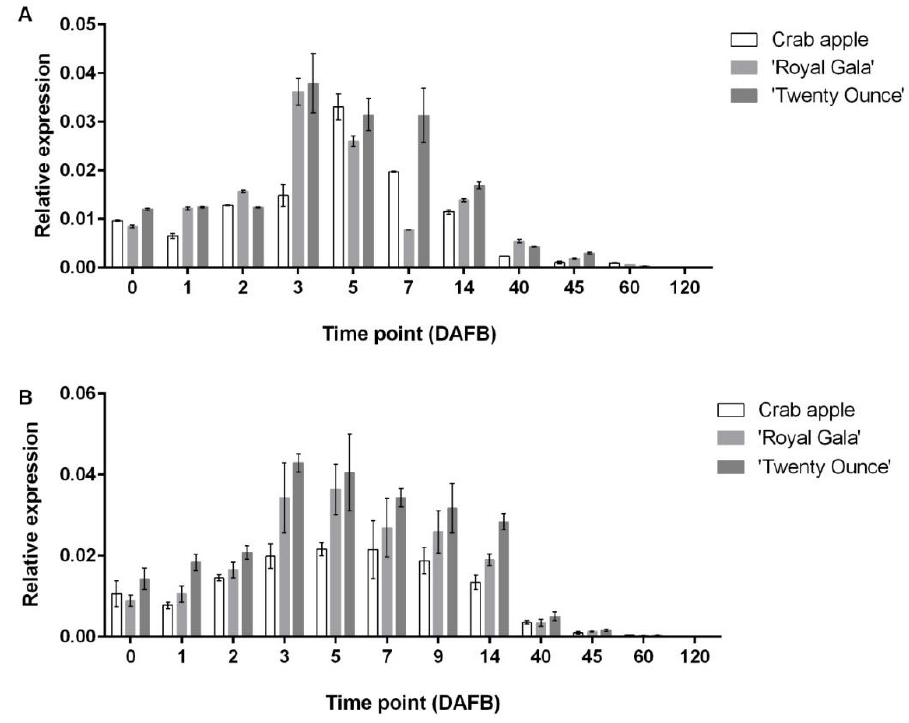
Figure 7. Differential expression of MdANT2 in three cultivars during Season 2 relative to MdGAPDH . ( A ) Relative expression in biological Replicate 1 (Rep1). ( B ) Relative expression in biological Replicate 2 (Rep2). Error bars = standard deviation; n = 3 (technical replicates). The expres- sions between markers were statistically different, ANOVA (two-factor), p - value ≤ 0.05. Season 1 testing of MdEXP3 expression in Royal Gala flowers and fruits revealed its high levels during the cell expansion stages. In Season 2 (Figure 8), MdEXP3 was most prominently found in Crabapple throughout the earlier stages. By contrast, Twenty Ounce expressed the highest levels of the cell expansion gene only as the fruit approached ma- turity (120 DAFB). These observations importantly signified that although each cultivar may do so in a temporally dissimilar manner, the cells of its fruit would nevertheless un- dergo the expansion process; this explains why all cultivars produced similar cell sizes before full bloom (0 DAFB) and at full ripening (120 DAFB).